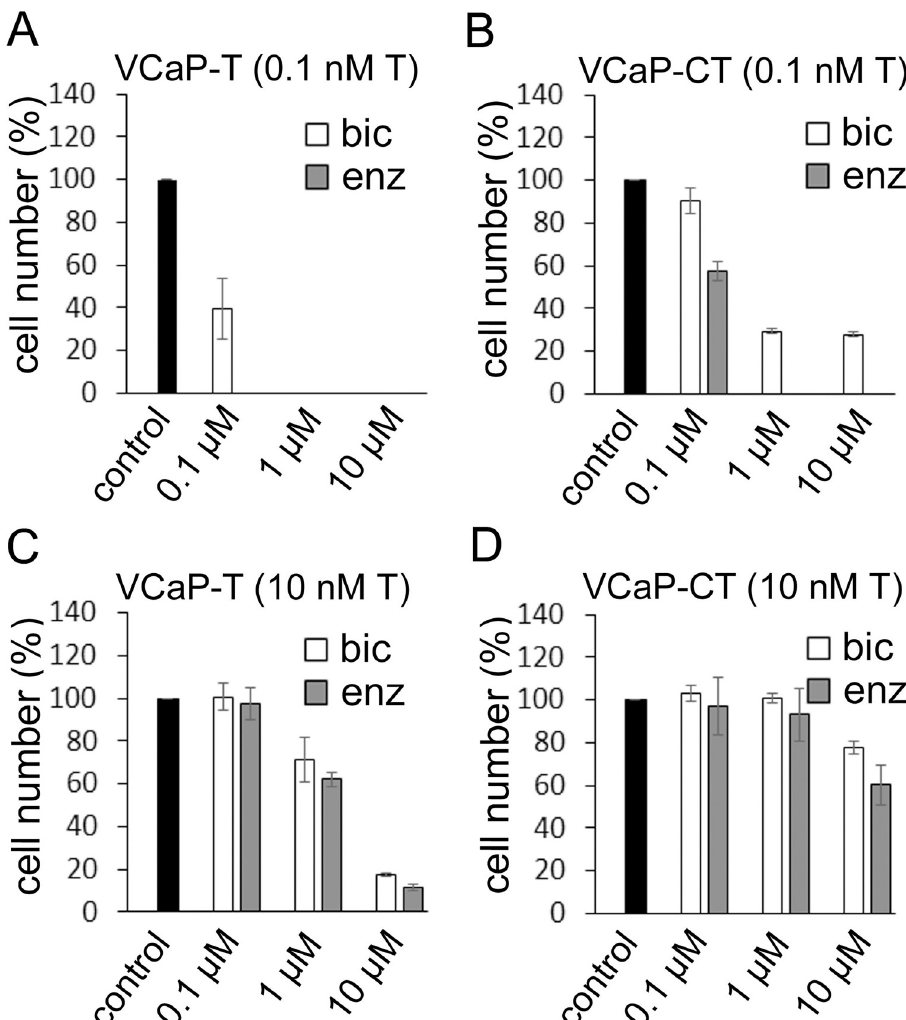
(B) Growth of VCaP-CT in the presence of 0.1 nM T and increasing concentrations of antiandrogens. (C) Growth of VCaP-T in the presence of 10 nM T and increasing concentrations of antiandrogens. (D) Growth of VCaP-CT in the presence of 10 nM T and increasing concentrations of antiandrogens. The cell numbers were measured after 7 days treatments and compared relative to the control (no antiandrogen) sample. Data are represented as mean ± SD and three separate replicates were